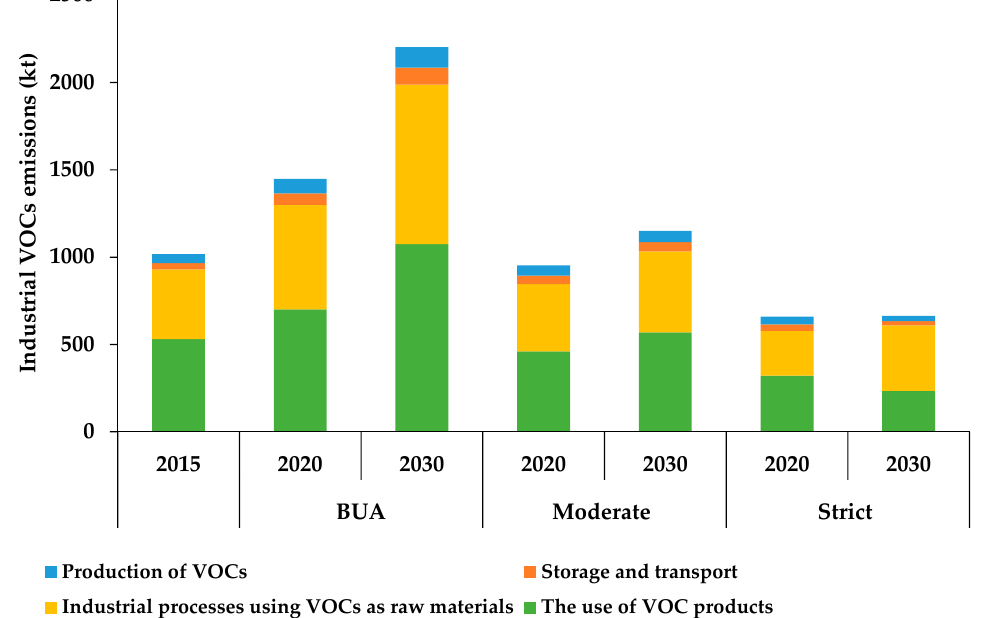
Figure 6. Prediction of industrial VOC emissions under the different scenarios in 2020 and 2030. Figure 6 also shows the reduction in VOC emissions from different industrial sectors under the different scenarios. A significant emission abatement would be achieved with the use of VOC products for all scenarios, with the exception of the strict scenario in 2030, where the emissions from industrial processes using VOCs as raw materials were